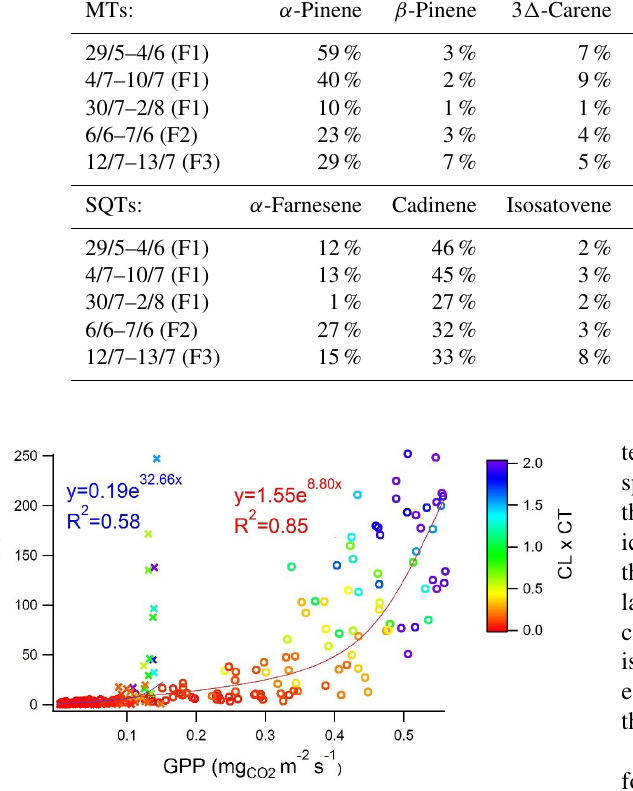
Figure 3. Isoprene emission rate vs. CO 2 gross primary produc- tion (GPP) at the beginning of summer (29 May–7 June; crosses and red fitting) and in July (4–13 July; dots and blue fitting) mea- sured at Lompolojänkkä fen in summer 2018. Colour corresponds to the strength of the light and temperature activation coefficient (CL × CT) in the range of 0.0–2.0. R 2 values are from the corre- sponding transformed straight lines (ln( y ), ln( x